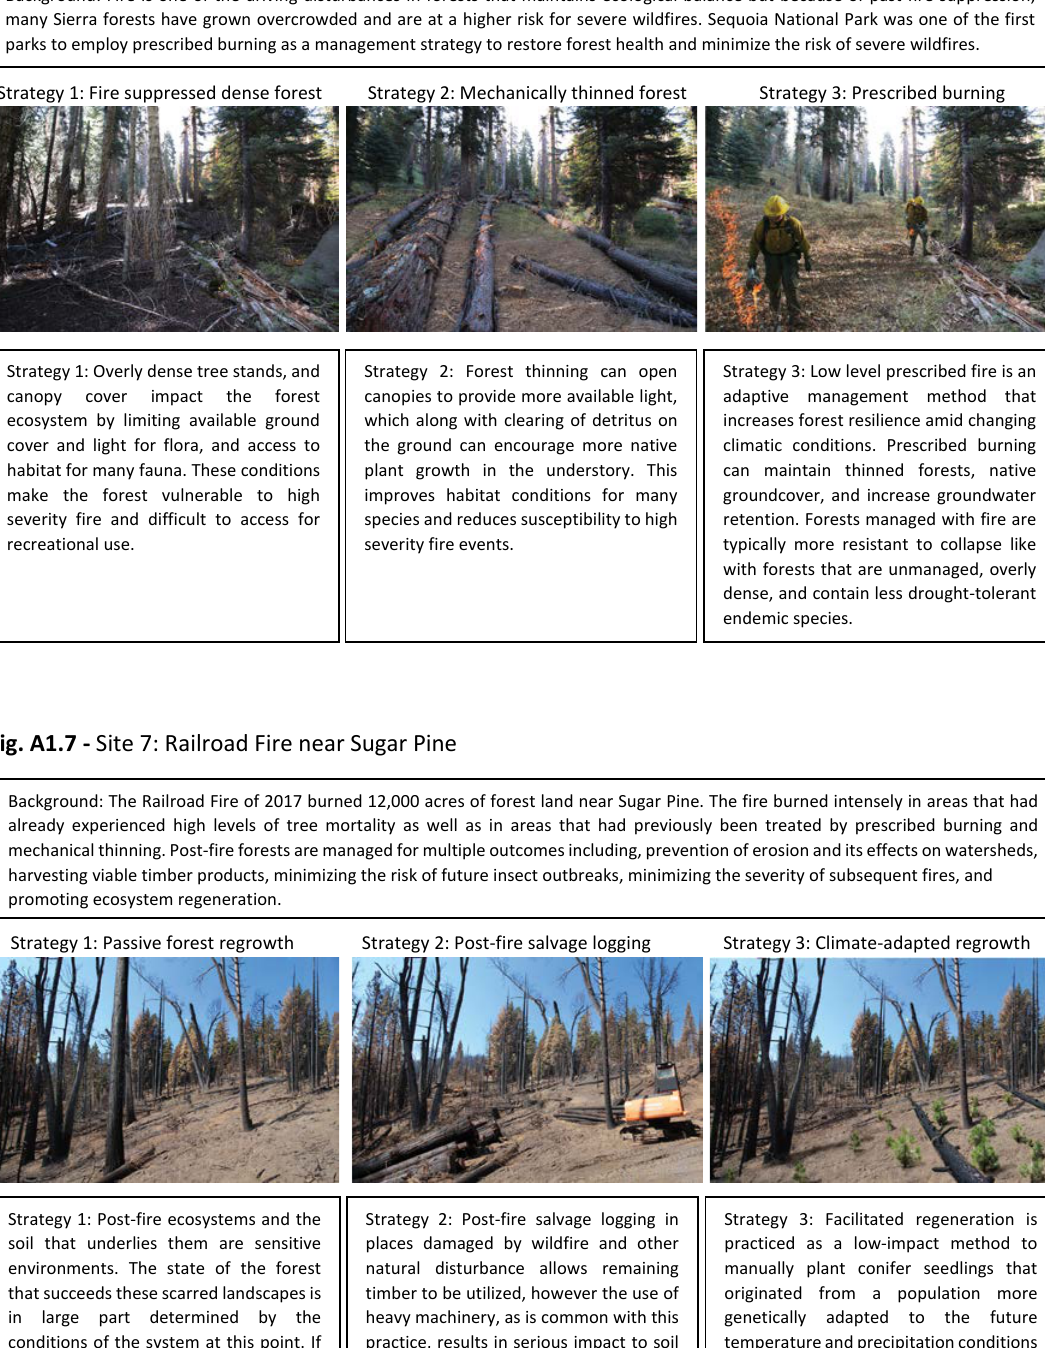
Fig. A1.6 - Site 6: Generals Highway Forest